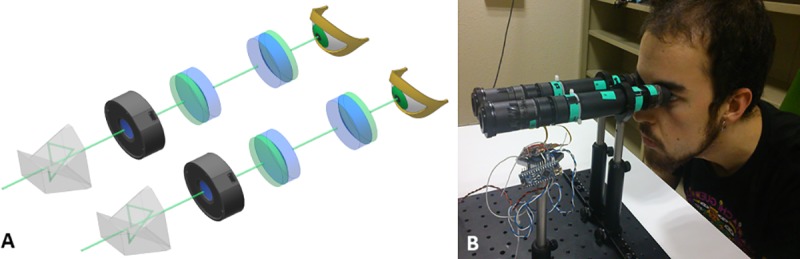
(A) Schematic diagram of the binocular vision simulator. L1 and L2 are projection lenses (50mm EFL) used for optically conjugating the eye and the tunable lens (TL). A Schmidt-Pechan prism is used for image re-inversion (B) Image of a subject viewing through the system. The individual has given a written informed consent (as outlined in PLOS consent form) to publish his photograph.